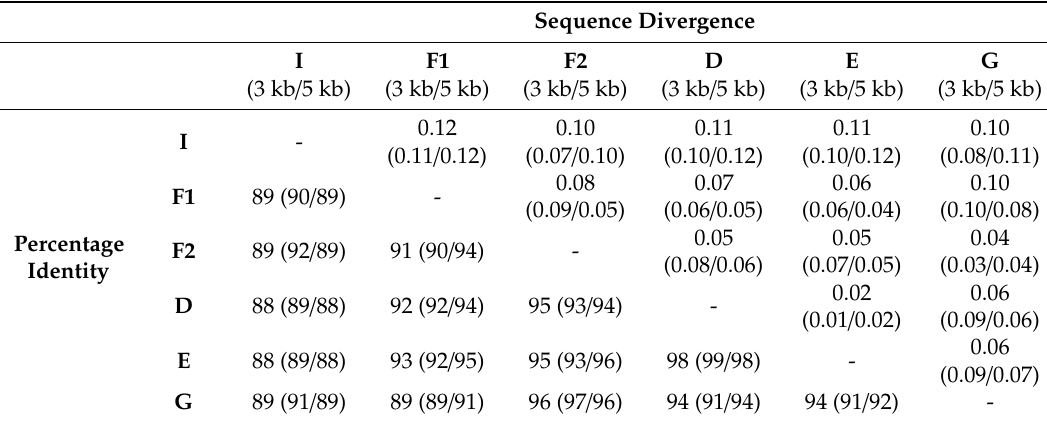
Table 3. Shown is the divergence (upper rows) and percentage identity (lower half) between full length reference sequences. In brackets are the estimates for the 3 and 5 kb amplicon regions only. Estimates were calculated using the sequences from NCBI listed in Table 1 and